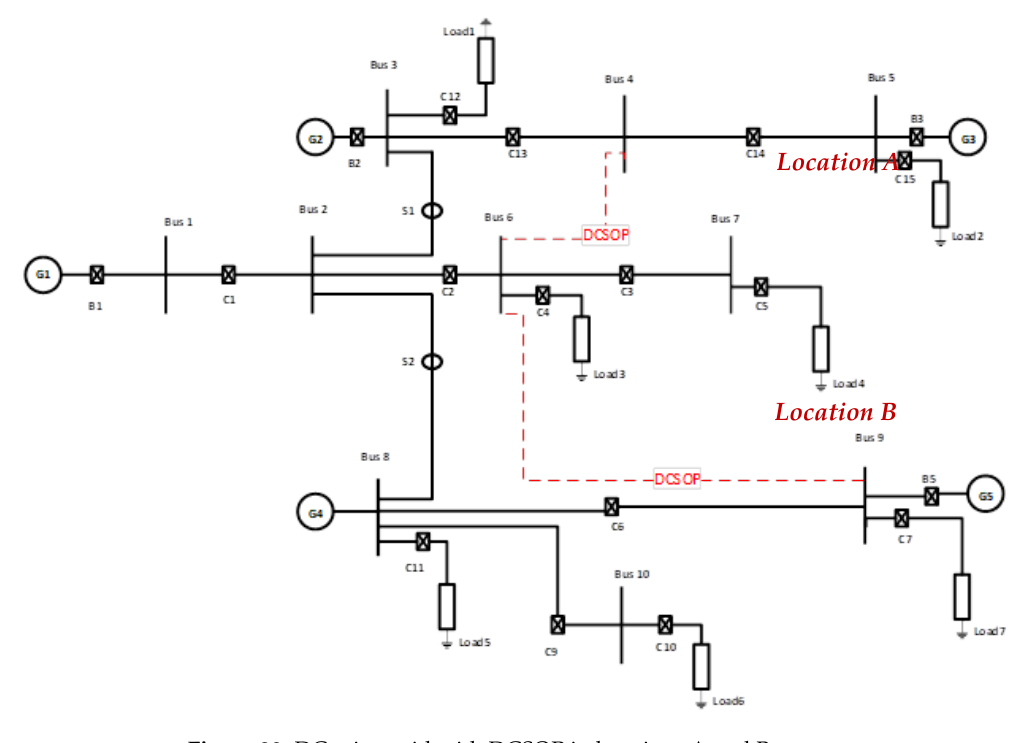
Figure 20. DC microgrid with DCSOP in locations A and B.